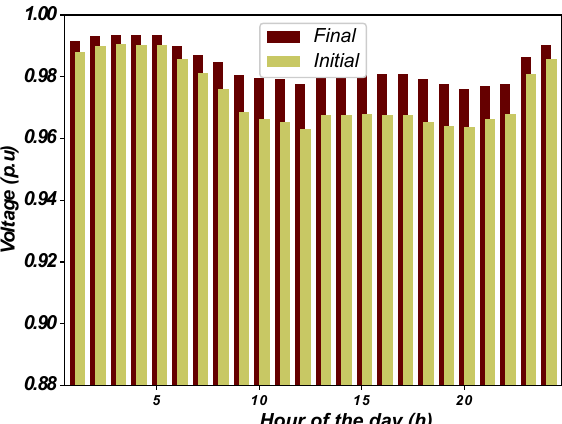
Figure 10. 19-bus and 20-branch system voltage levels (variable).